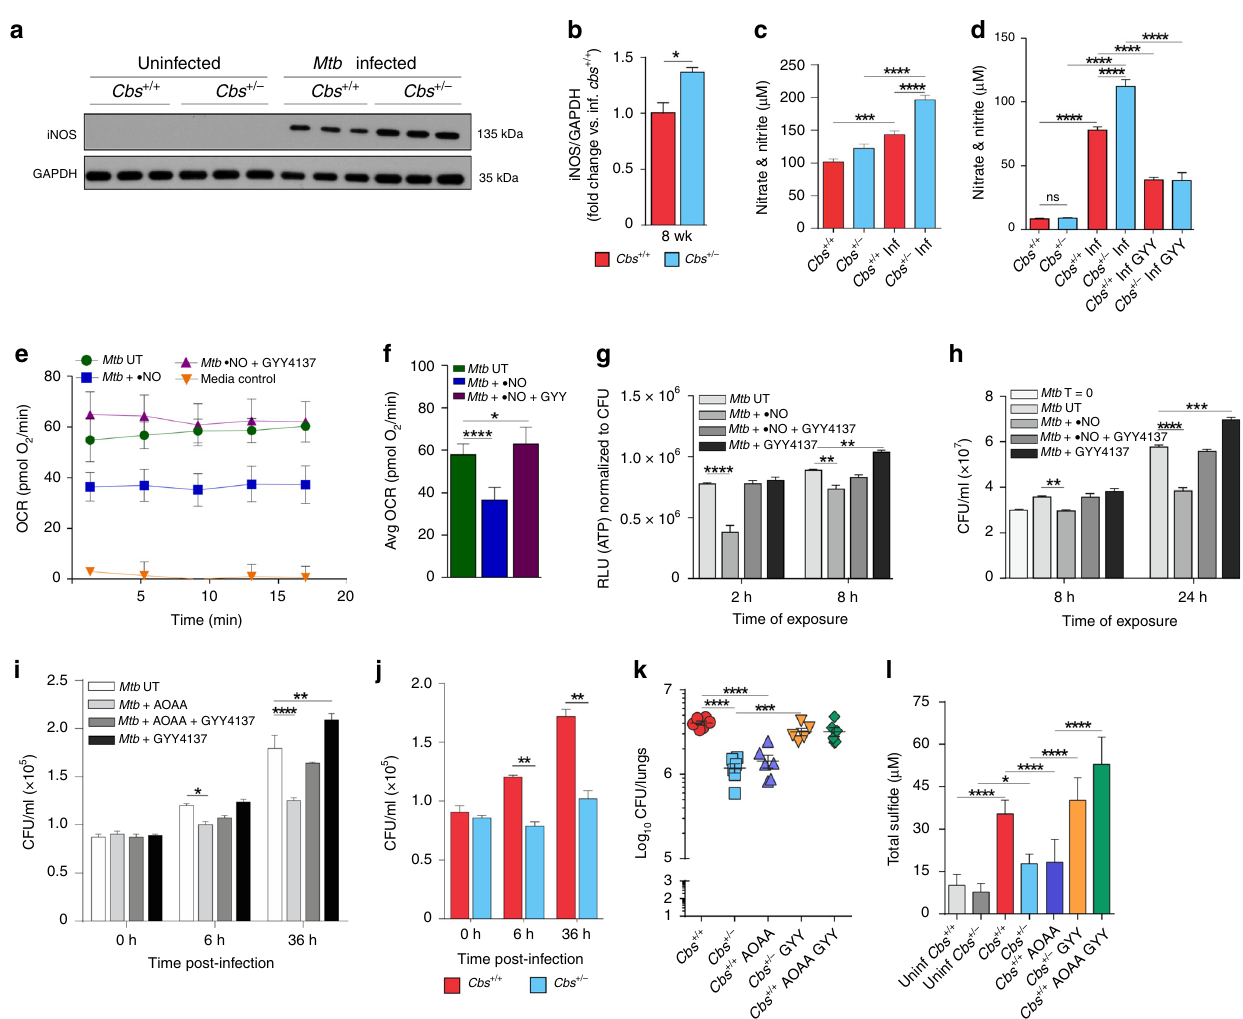
Fig. 6 Interaction between (cid:129) NO and H 2 S and pharmacological modulation of sul fi de levels in mice. a Representative western blot and b densitometry analysis of iNOS in mouse lungs at 8 weeks post infection ( n = 3 animals per group). c Nitrate and nitrite levels in the sera of infected (Inf) and uninfected mice and d the culture medium of infected mouse macrophages exposed to 25 µ M GYY4137 for 36 h. Data in ( c ) and ( d ) are pooled from two independent experiments ( n = 7 − 8 animals per group). e OCR pro fi le and f average OCR of Mtb cells exposed to (cid:129) NO (DETA/NO; 250 µ M), (cid:129) NO followed by GYY4137 (10 µ M), or untreated (UT) in XF media ( n = 6 − 8). Media control contained no cells. g ATP levels (shown as RLU normalized to CFU) in Mtb cells treated ( (cid:129) NO, GYY4137, or (cid:129) NO and GYY4137) or untreated (UT) for 2 or 8 h. h CFUs after 8 and 24 h of exposure. T = 0 indicates CFU at the start of